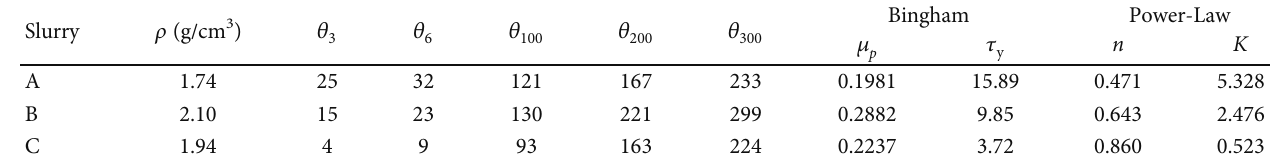
Table 2: Densities and rheometer parameters for three types of cement